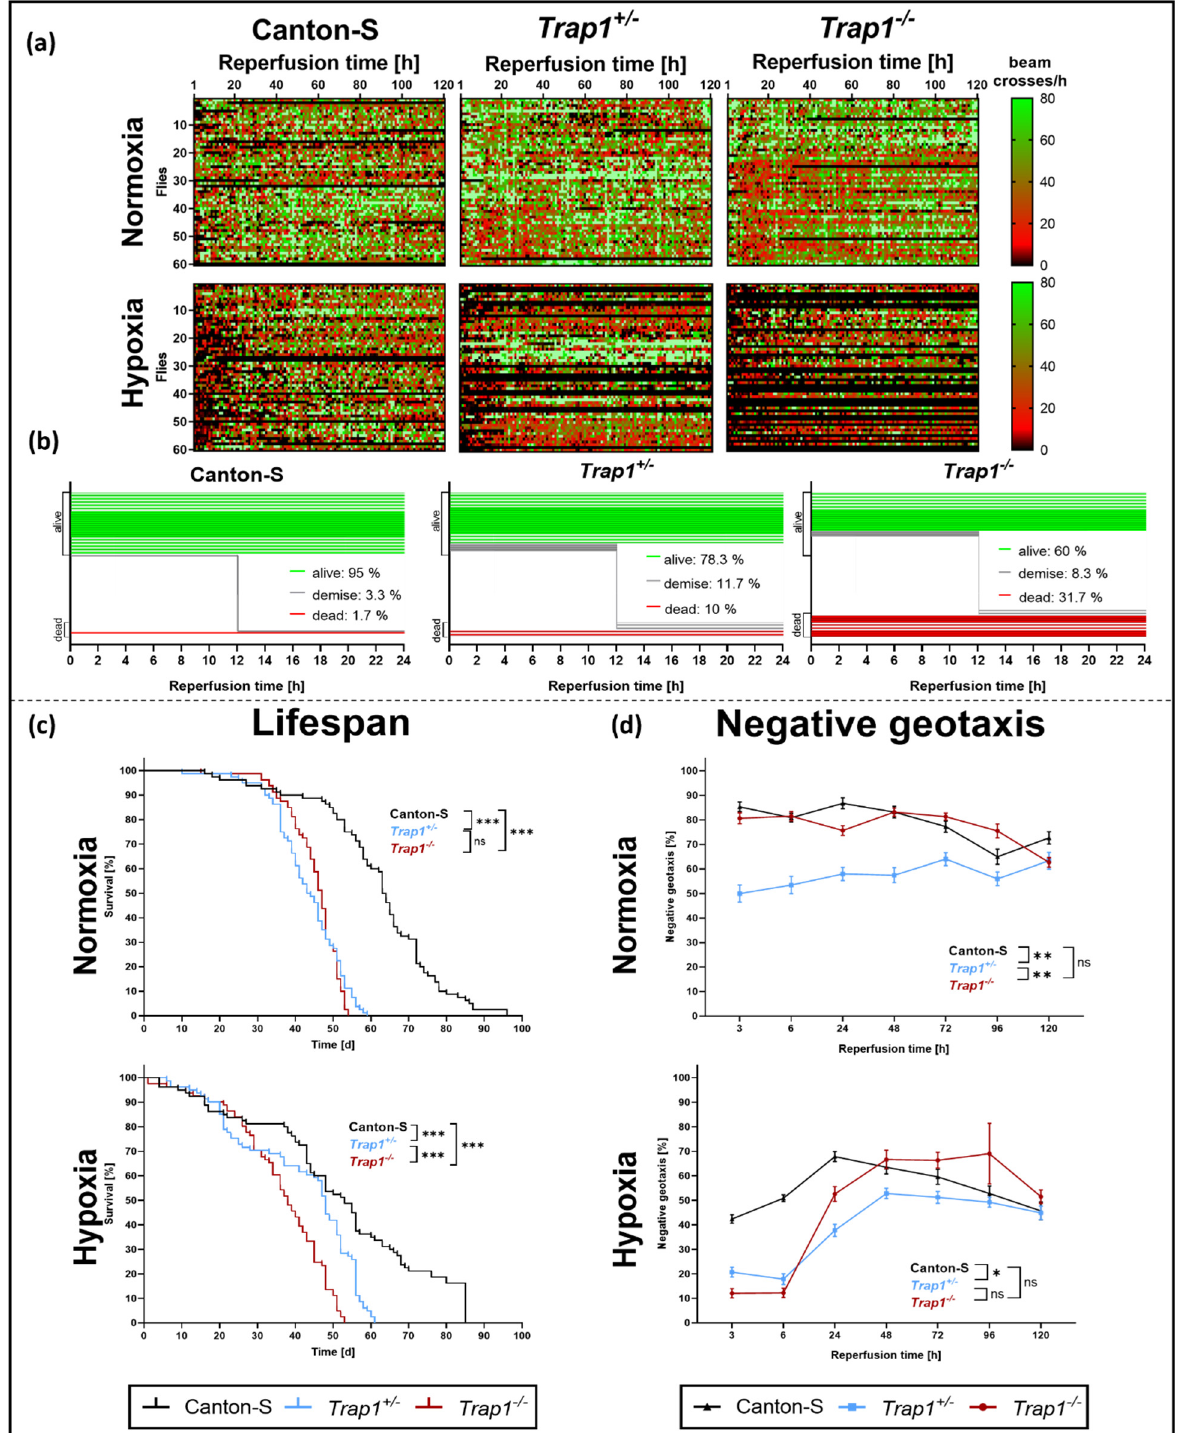
Figure 2. Activity, lifespan, and negative geotaxis of Canton-S, Trap1 +/ − and Trap1 − / − D. melanogaster after 3 h of severe hypoxia followed by 120 h of reperfusion. ( a ) Heatmaps displaying the activity of Canton-S, Trap1 +/ − and Trap1 − / − after 3 h of severe hypoxia (<0.3 % O 2 ) or normoxia (21 % O 2 ) followed by 120 h of reperfusion. Each cell shown is the absolute value of beam crosses per hour per fly, represented by color. Black: no activity, red: moderate activity, green: high activity. ( b ) Quantification of survival, instant death, and reperfusion-dependent death of Canton-S , Trap1 +/ − and Trap1 − / − D. melanogaster in the first 24 h after 3 h of severe hypoxia (<0.3 % O 2 ). ( c ) Kaplan-Mayer-curves of Canton-S, Trap1 +/ − and Trap1 − / − flies subjected to 3 h of hypoxia or normoxia. The statistical significance was determined using the chi-squared-based log-rank, Mantel-Cox test. * p < 0.05, ** p < 0.01, *** p < 0.001 ( d ) Mortality adjusted negative geotaxis of Canton-S, Trap1 +/ −